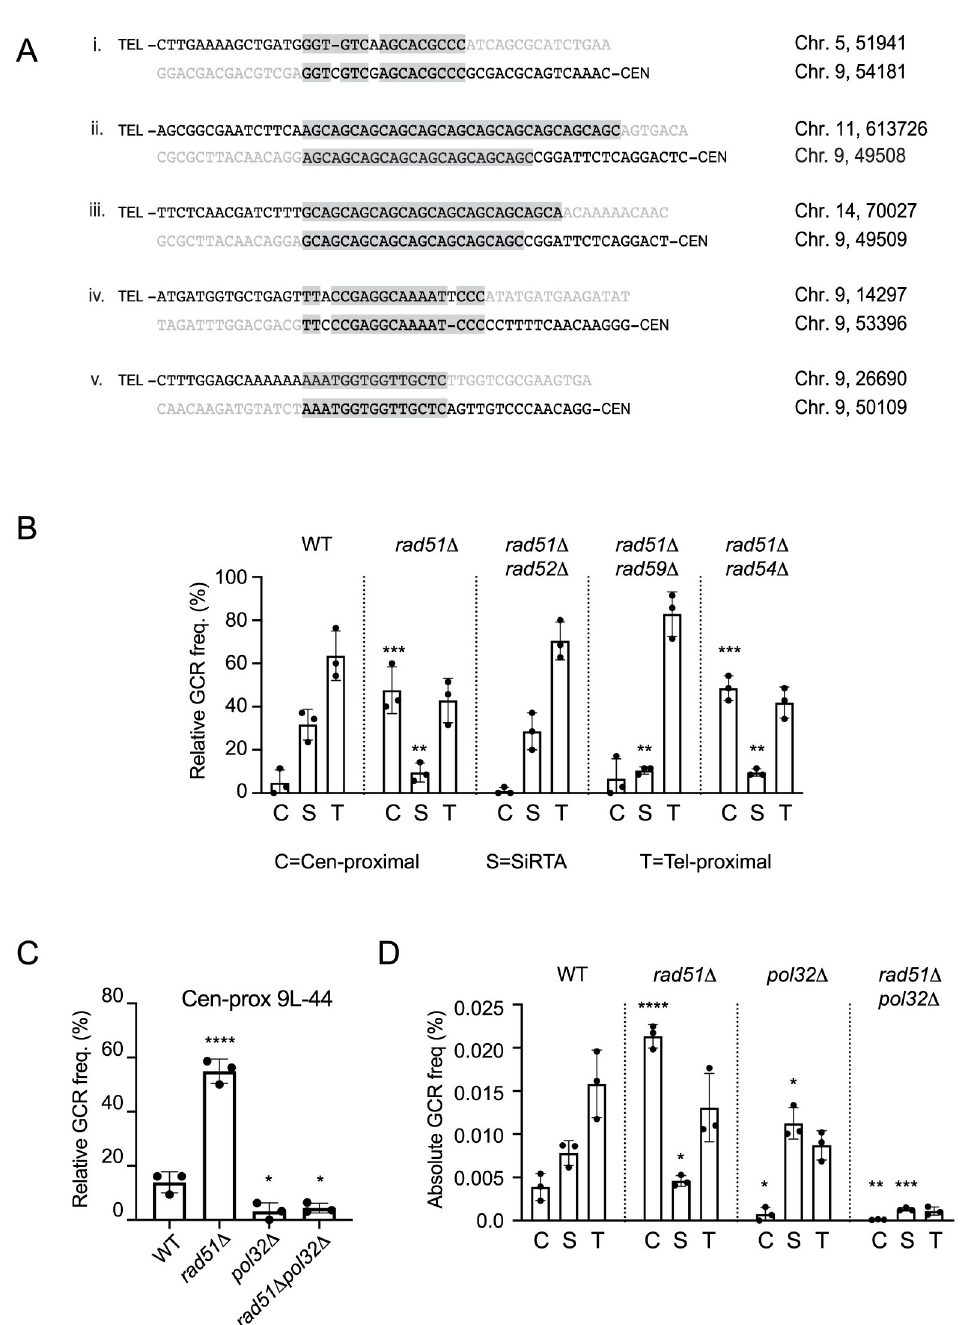
Fig 3. Microhomology-mediated repair requires Rad52, Pol32, and Rad59 and is inhibited by Rad51. (A) Unique breakpoint sequences identified by nanopore sequencing in twelve independent rad51 Δ strains are shown. Event (iv) was recovered independently eight times, while the other rearrangements occurred once. Bases in gray are present on the original chromosome, while bases in black are those retained in the rearranged chromosome. The shaded regions indicate microhomologies utilized in mediating repair. The chromosome coordinate of each rearrangement is indicated. Additional information is available in S1 Data. (B) The relative GCR frequency in each region on chromosome 9 is shown in the indicated strains. C, S, and T indicate centromere-proximal, SiRTA, and telomere-proximal events, respectively. Data for rad51 Δ rad52 Δ are repeated from Figs 1B and 2A for comparison. Values are averages from 3 independent experiments with standard deviation. For the centromere-proximal and SiRTA regions only, averages were compared to the WT sample in that same region by ANOVA with Dunnett’s multiple comparisons test. (C) The relative GCR frequency in the region centromere-proximal to SiRTA 9L-44 is shown for the indicated strains. Averages indicated by asterisks are statistically different by ANOVA with Dunnett’s multiple comparisons test. (D) The